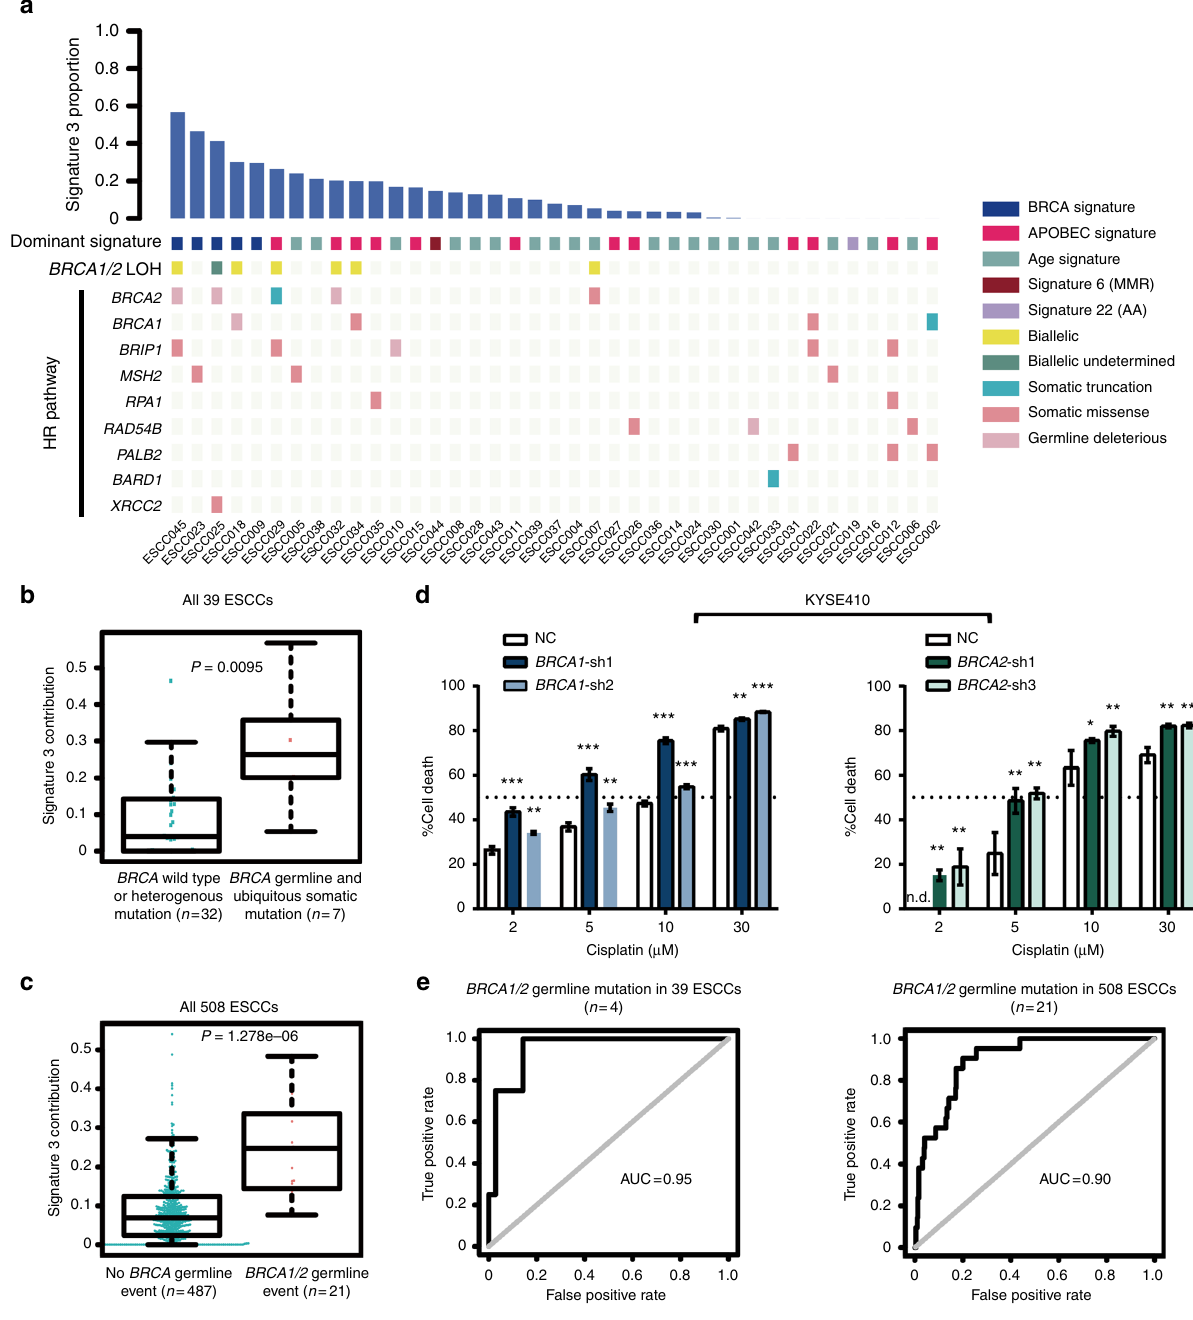
Fig. 4 BRCA1/2 signature as a potential therapeutic target for ESCC. a Top bar represents the contribution of signature 3 in each ESCC. Colored squares indicate dominant mutational signature and LOH status of BRCA1/2 . Deleterious germline and somatic mutations in the HR pathway are shown at the bottom of the heat map. b , c Comparison of signature 3 activity in ESCCs with or without BRCA1/2 mutation in 39-Mseq cohort ( b ) and additional 508- WGS cohort ( c ). d Knockdown of BRCA1 and BRCA2 signi fi cantly increased sensitivity of KYSE410 cells to cisplatin. * P < 0.05, ** P < 0.01, *** P < 0.001, n.d. means not detected. Error bars are de fi ned as s.d. Source data are provided as a Source Data fi le. e Receiver operating characteristic (ROC) curves for alterations in BRCA1/2 germline mutation predicted based on signature 3 levels in 39-Mseq cohort (left) and additional 508-WGS cohort (right)